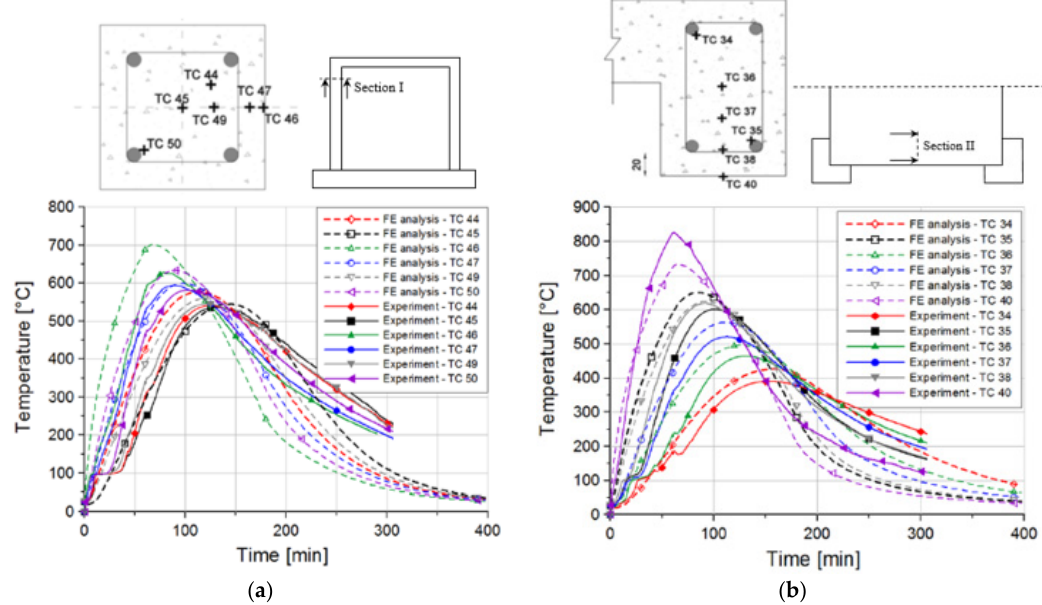
Figure 8. Experimentally measured and numerically obtained distribution of temperatures (local) at different locations: ( a ) column and ( b ) slab.